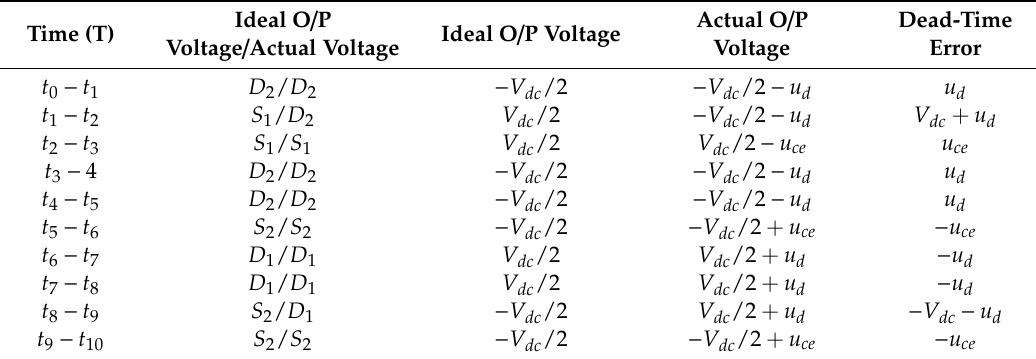
Table 1. The error between the ideal voltage and the actual